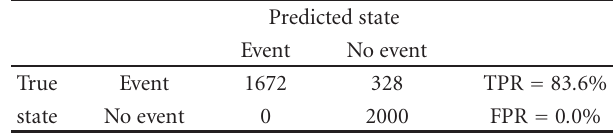
Table 4: Sample detection decision matrix (DDM). Table 5: Detection decision